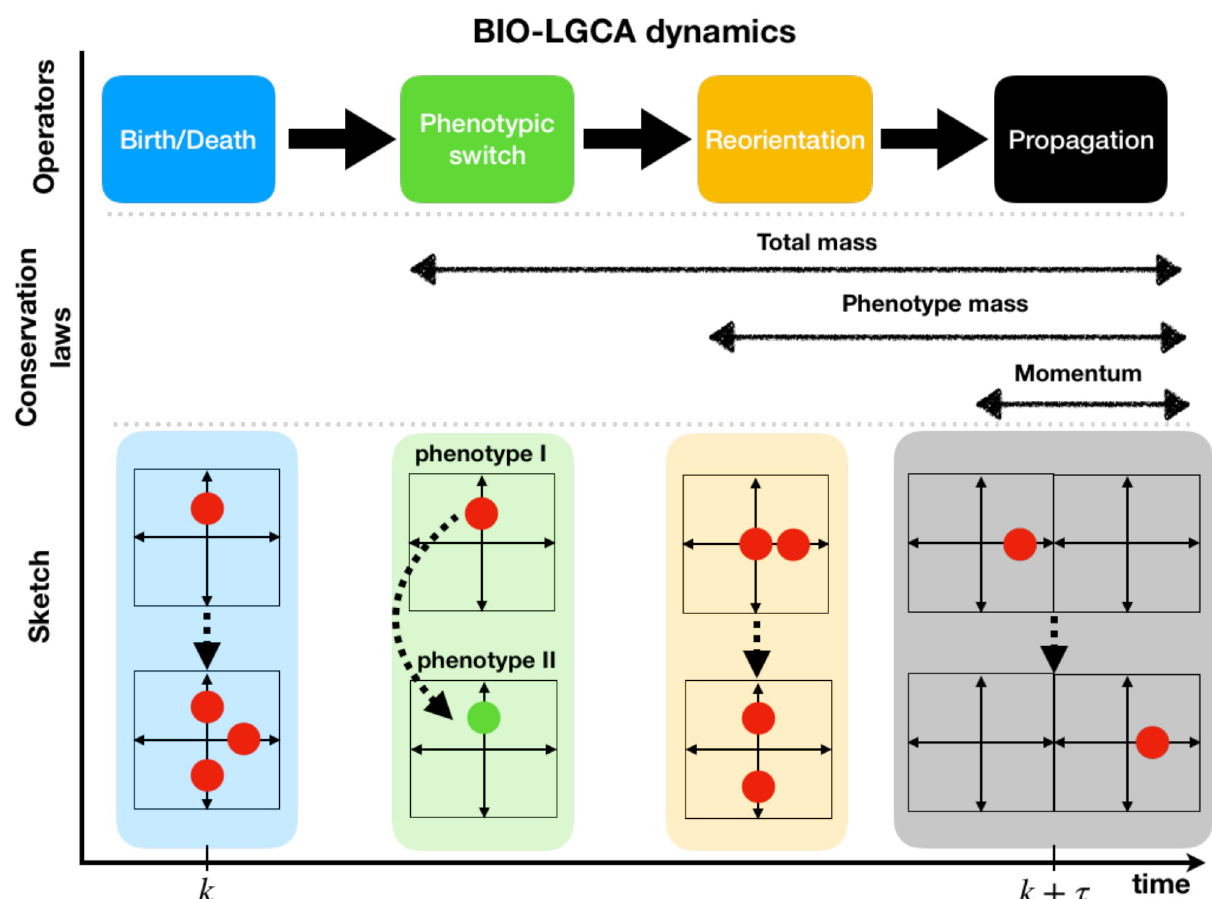
Fig 3. Operator-based dynamics of the BIO-LGCA. Propagation P , reorientation O , phenotypic switch S , and birth/death operators R (top); conservation laws maintained by the different operators (middle); sketches of the operator dynamics (bottom), see text for explanations.